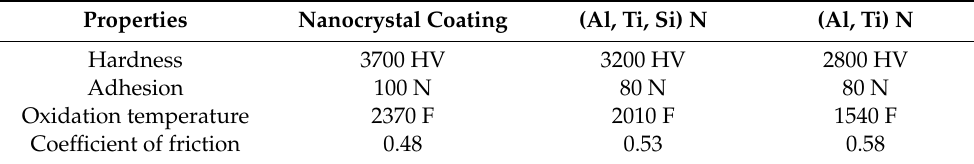
Figure 6. Milling tool: schematic presentation of geometry. Table 2. The features of nanocrystal coating in comparison with other